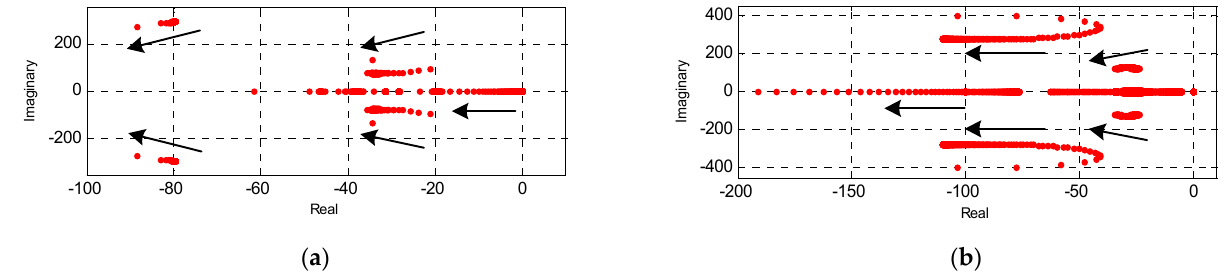
Figure 5. The system root locus diagram for the changes of J and K. ( a ) The root locus of the inertia coefficient J of the VSG changes from 0.04 to 10; ( b ) the root locus of the excitation coefficient K of the VSG changes from 0.001 to 100.